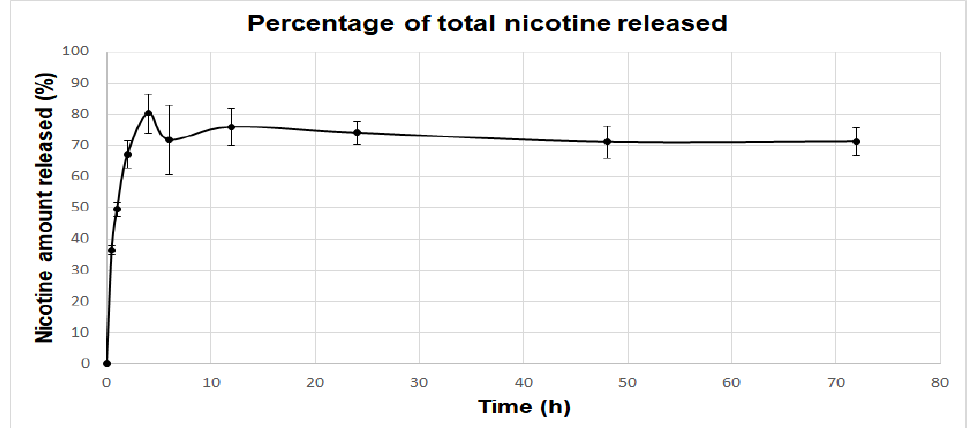
Figure 6. Percentage of the total amount of nicotine injected in the Franz Cell released at different time points. The initial release stage can be characterized as the “initial burst”, where the amount of nicotine that is adsorbed by the nanocapsule surface is released. The release profile then reaches a plateau of nicotine concentration. Results are displayed as mean and standard errors.